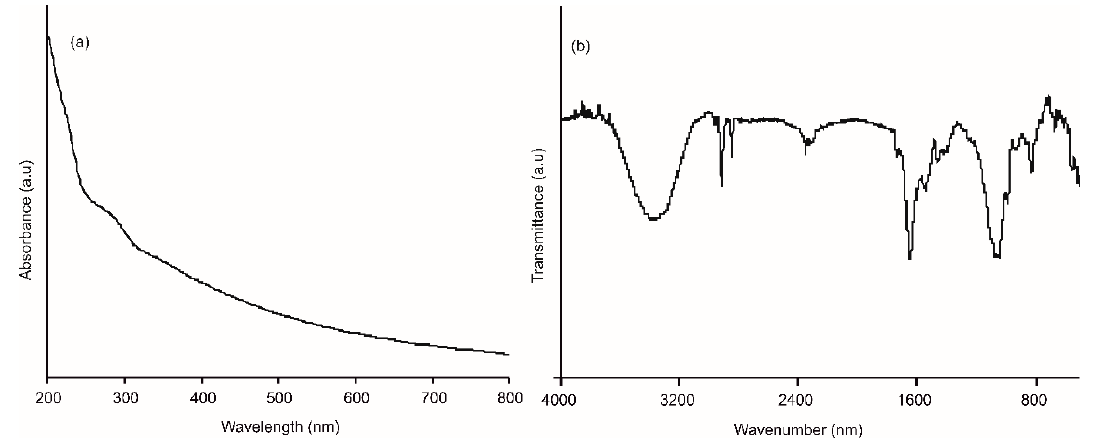
Figure 2. Intensity vs. potential regression curves of indium tin oxide (ITO) (black) and ITO- AgNWs (red).